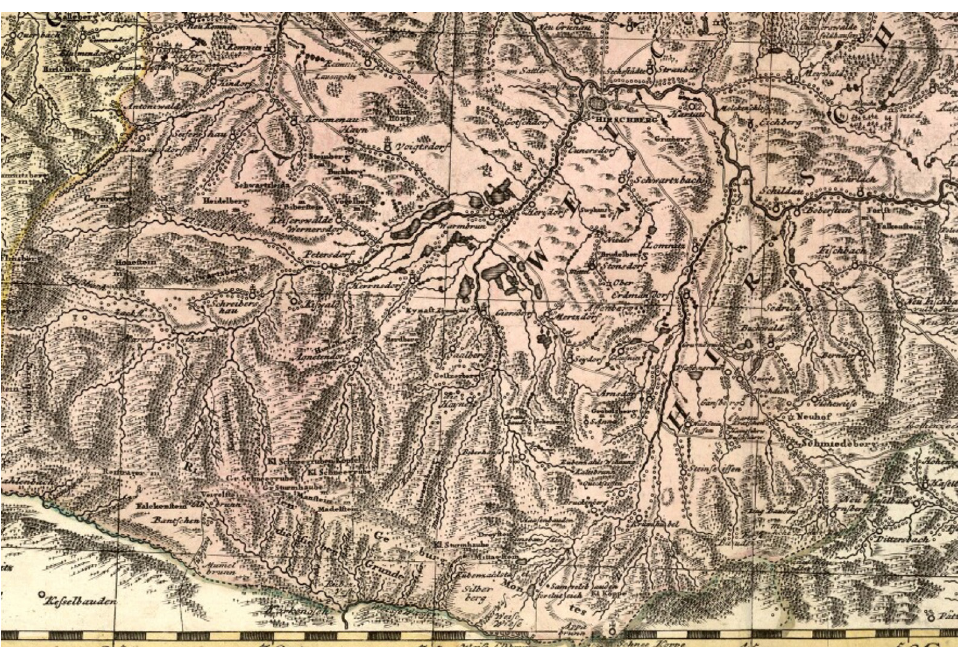
Fig. 1. Karkonosze Mts. and Jelenia Góra Basin on the map of the Duchy of Jawor in Atlas of Silesia from 1752. Relief presented with the method of semi-perspective (source: www.mollova mapova sbirka)